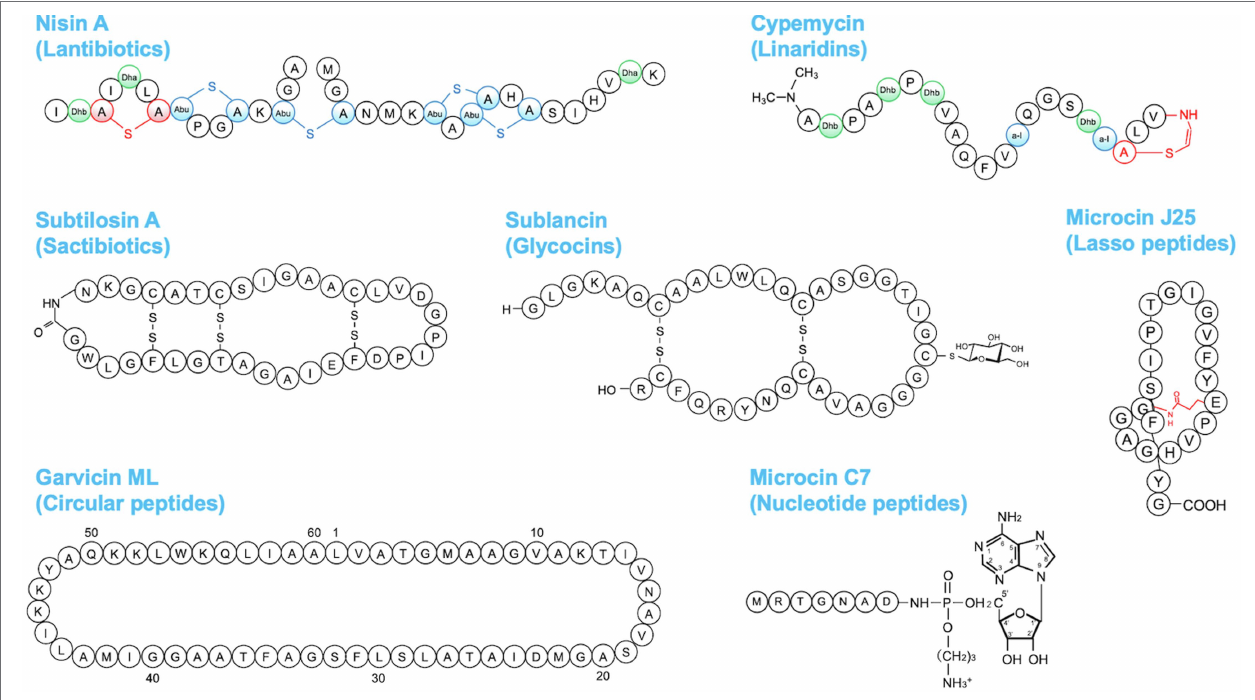
FIGURE 3 | Amino acid structures of some bacteriocins belonging to different